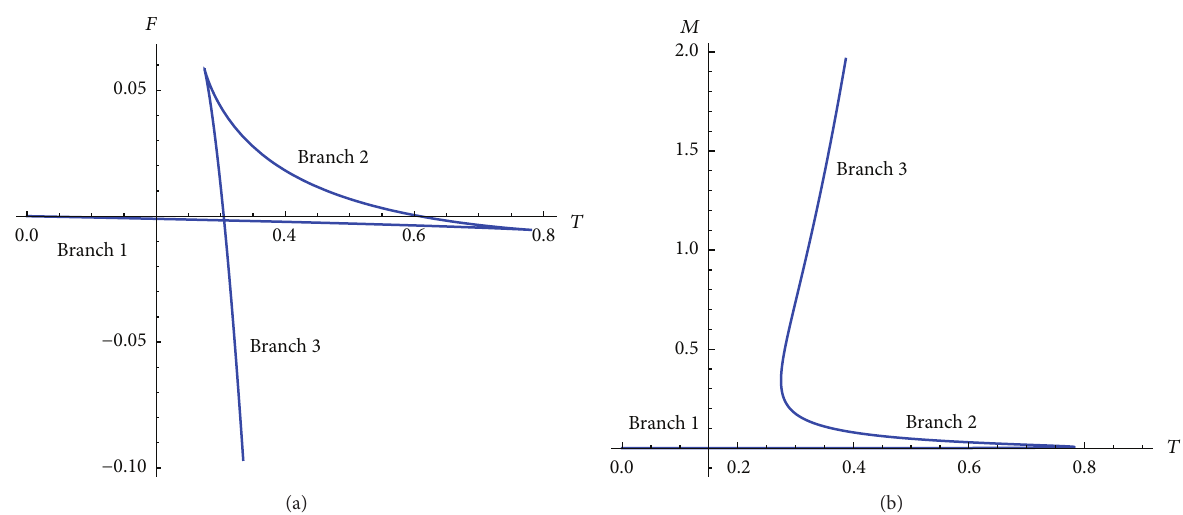
Figure 3: Example plot ( 𝑛 = 4 ) of (a) free energy 𝐹 and (b) mass versus 𝑇 for the fixed 𝑞 < 𝑞 𝑐 ensemble; both 𝑛 = 3, 4 show similar features.